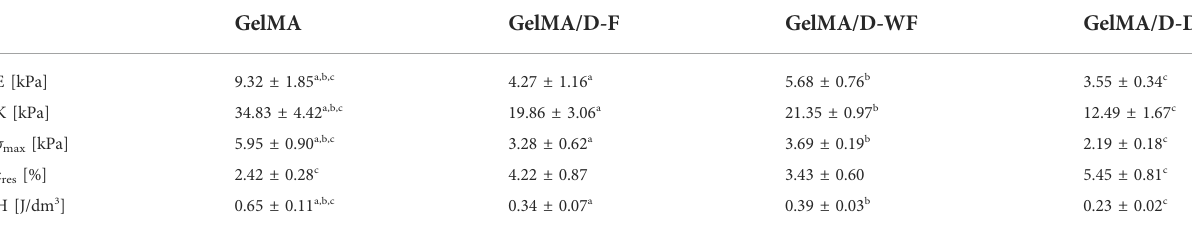
TABLE 2 Values of the considered mechanical parameters obtained in the compression test performed on the four formulations considered. The average standard deviation of the parameter is shown in the